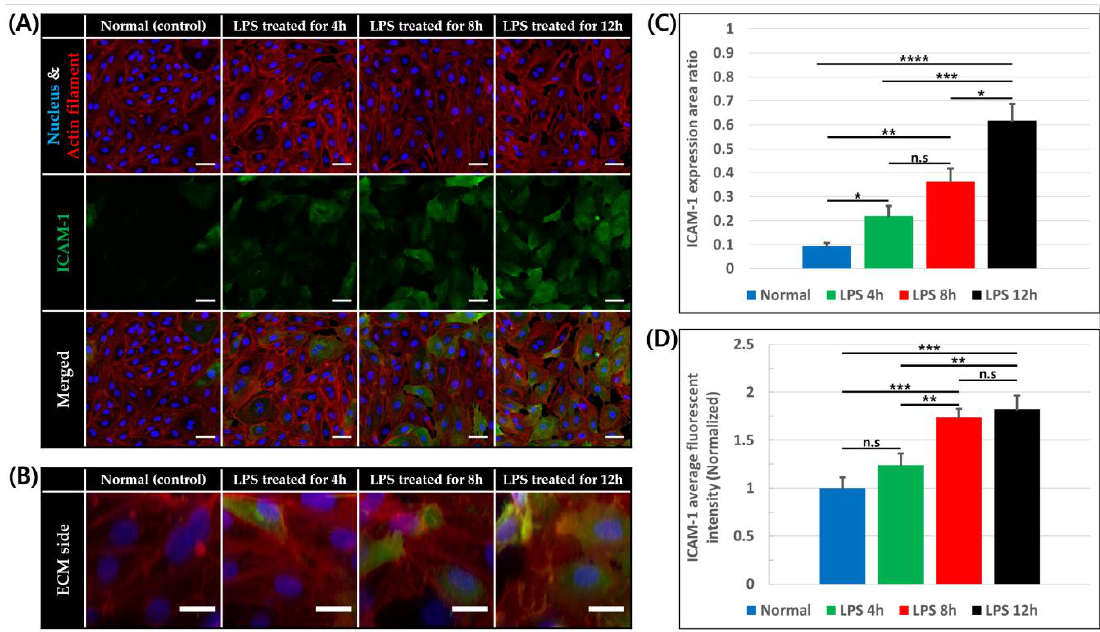
Figure 3. ICAM-1 expression of endothelial cells of 0, 4, 8, and 12 h after LPS treatment. ( A ) Confocal image of endothelial cells on basal plane stained for nucleus (blue), actin filament (red), and ICAM-1 (green), scale bar = 50 μm. ( B ) Z-stack image of endothelial cells on ECM side stained for nucleus (blue), actin filament (red), and ICAM-1 (green), scale bar = 20 μm. ( C ) Ratio of ICAM-1 expression area to endothelial cell area on basal plane (n = 3 × 3, n.s: not significant *: p < 0.05, **: p < 0.01, ***: p < 0.001, ****: p < 0.0001) ( D ) Average fluorescent intensity of ICAM-1 on basal plane normalized by mean of normal condition (n = 3 × 3, n.s: not significant, *: p < 0.05, **: p < 0.01, ***: p < 0.001).